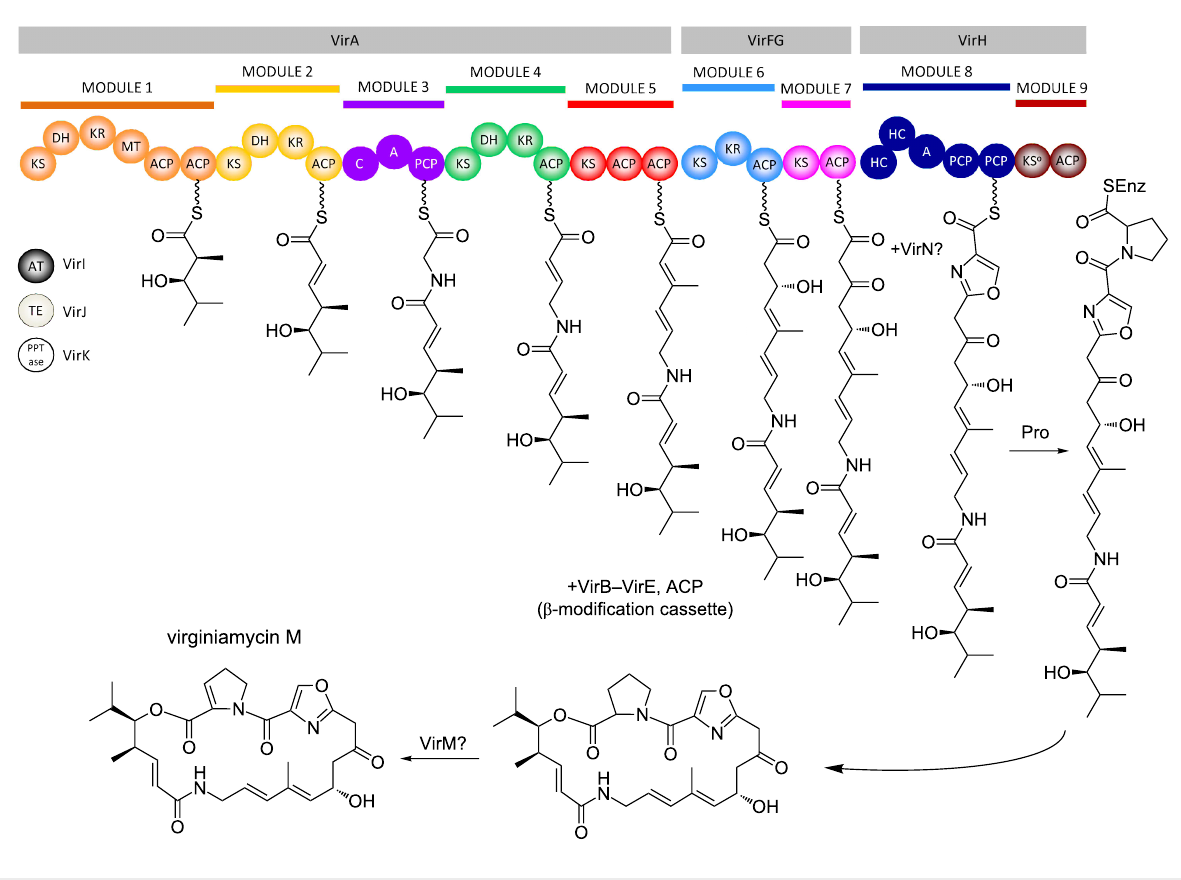
Figure 4: Schematic of the virginiamycin PKS from Streptomyces virginiae , a member of the trans -AT PKS family [11]. The PKS comprises at least three subunits, VirA, VirFG and VirH (the published cluster [14] is incomplete, as modules for starter unit selection and introduction of proline have not yet been identified). The system incorporates many features characteristic of this second class of modular PKS, including a trans -acting acyl trans- ferase VirI, duplicated domains (ACPs of modules 1 and 5 and peptidyl carrier proteins (PCPs) of module 8), nonribosomal peptide synthetase (NRPS) modules (3 and 8), an inactive domain (KS o of module 9), and a set of trans -acting enzymes which introduce a β -methylation into the chain.